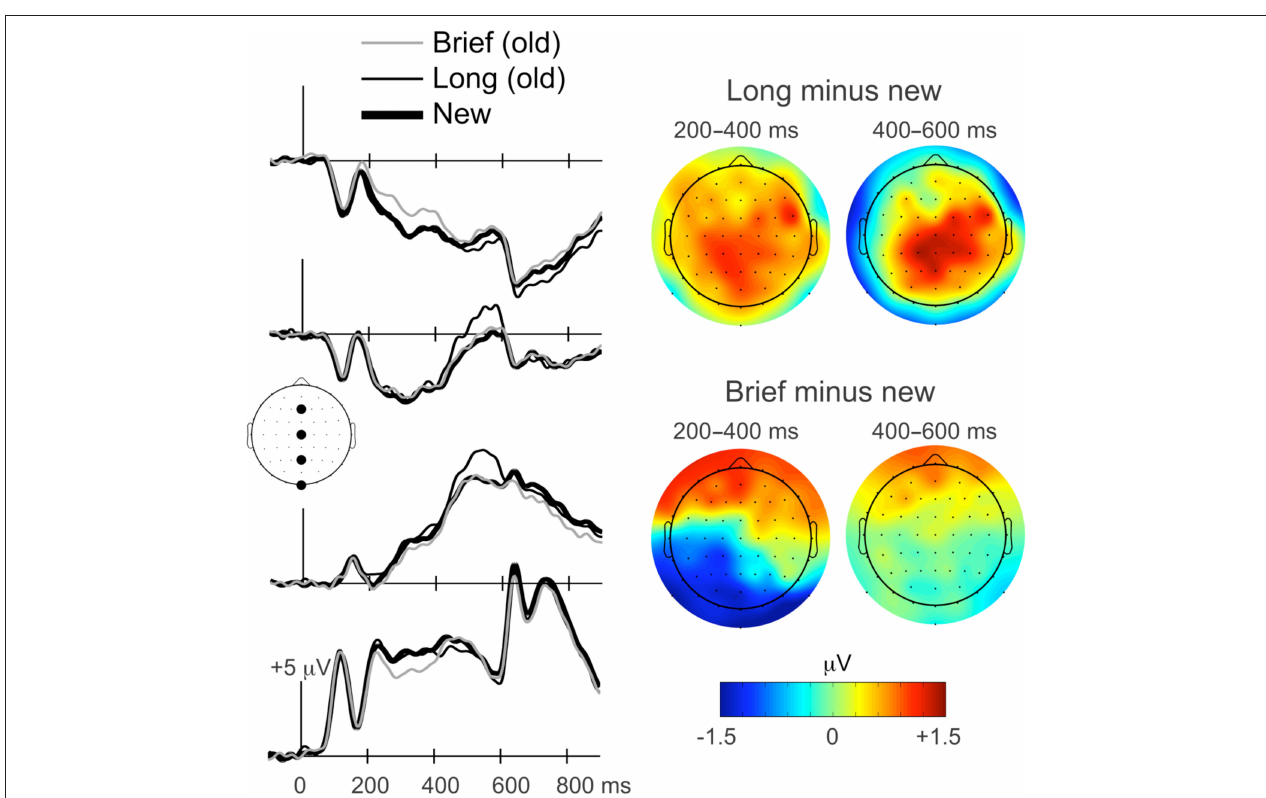
the left-posterior ( p < 0.001) and right-posterior ( p < 0.001) clusters. The Brief old/new difference for the left-anterior cluster approached significance ( p = 0.07). Old/new differences at all other clusters for the Brief and Long conditions were non-significant ( p -values > 0.11). For the 400–600 ms interval, the condition-by-cluster interaction was also significant [ F (3.2,41.6) = 3.2, p = 0.03]. Old/new differences were significant only for the Long condition for the left-central ( p = 0.002) and right-central ( p < 0.001) clusters. Old/new differences at all other clusters for the Brief and Long conditions were non-significant ( p -values >